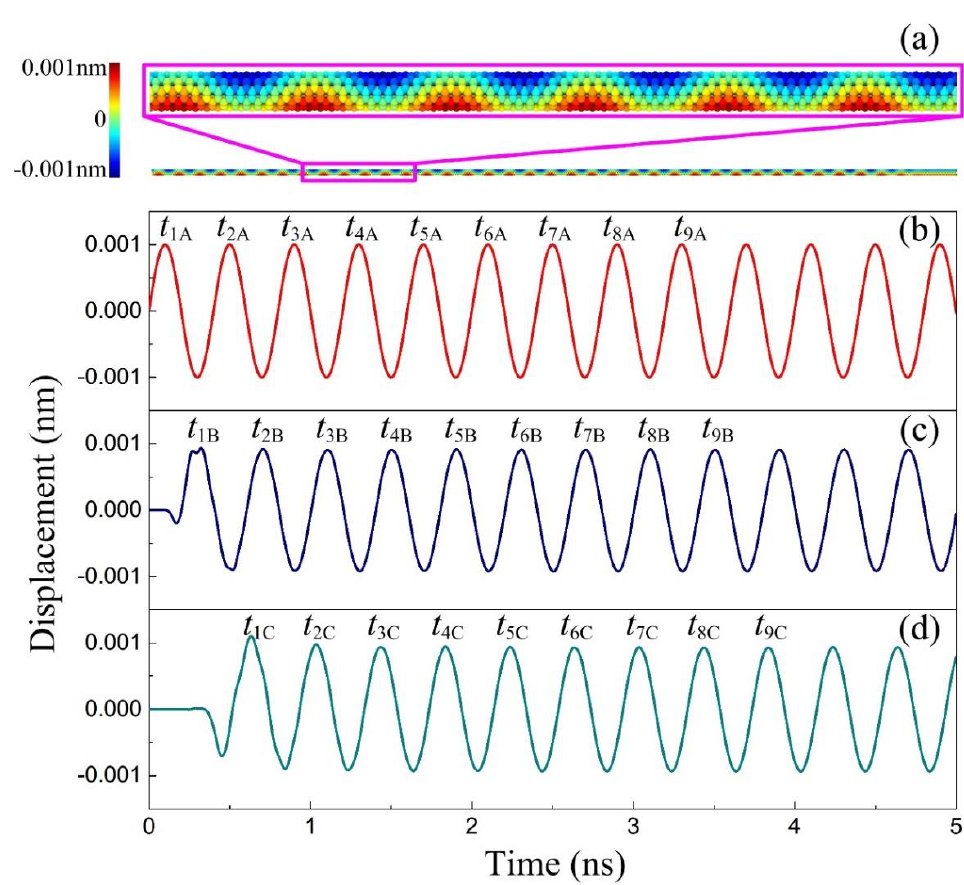
Figure 2. Molecular dynamics (MD) simulations of flexural wave propagation in a carbon atom chain-filled SWCNT (CCSC). ( a ) A snapshot of the displacement nephogram in the y direction of the (5, 5) SWCNT; ( b ) the input wave with frequency f = 2.5 THz at the edge layer of the SWCNT, where subscripts i in t iA represent the number of the wave peak; ( c ) the wave at section B, which is 2.25 nm ahead of section A; ( d ) the wave at section C, which is 4.69 nm ahead of section A.